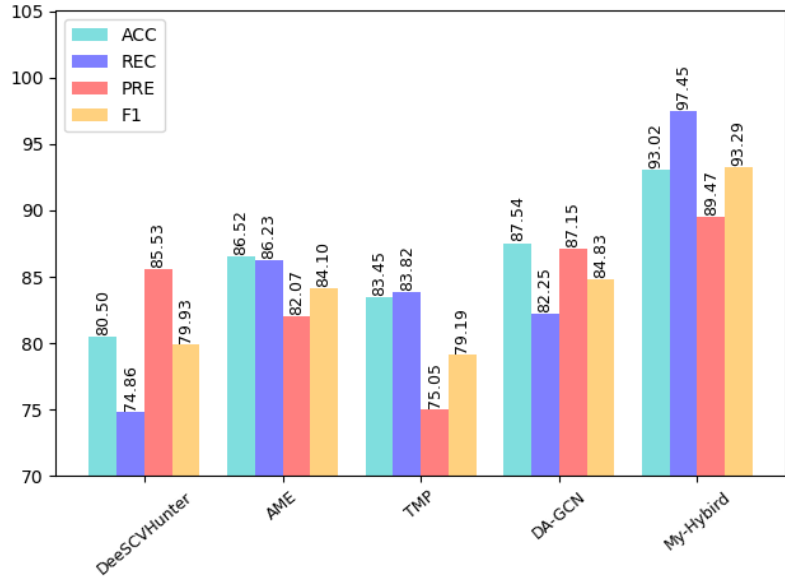
Figure 13. Timestamp vulnerability detection results.